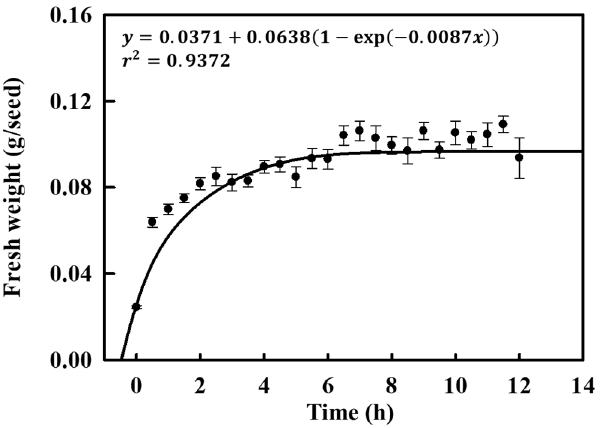
Figure 1. Imbibition curve of coastal glehnia seeds for 12.5 h. The vertical bars indicate standard errors ( n = 10).